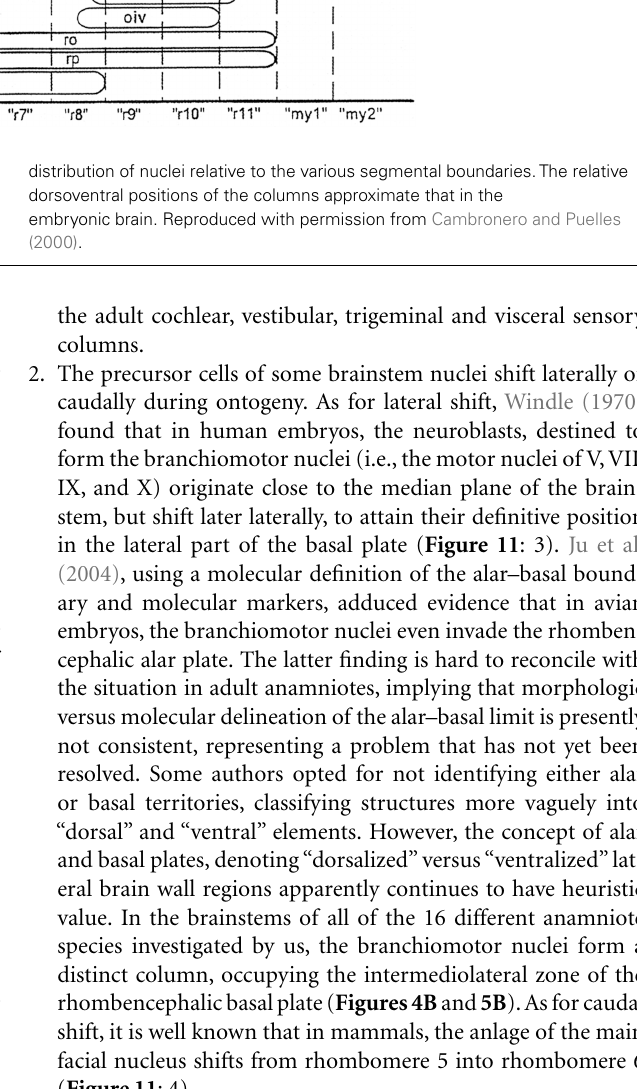
distribution of nuclei relative to the various segmental boundaries.The relative dorsoventral positions of the columns approximate that in the embryonic brain. Reproduced with permission from Cambronero and Puelles